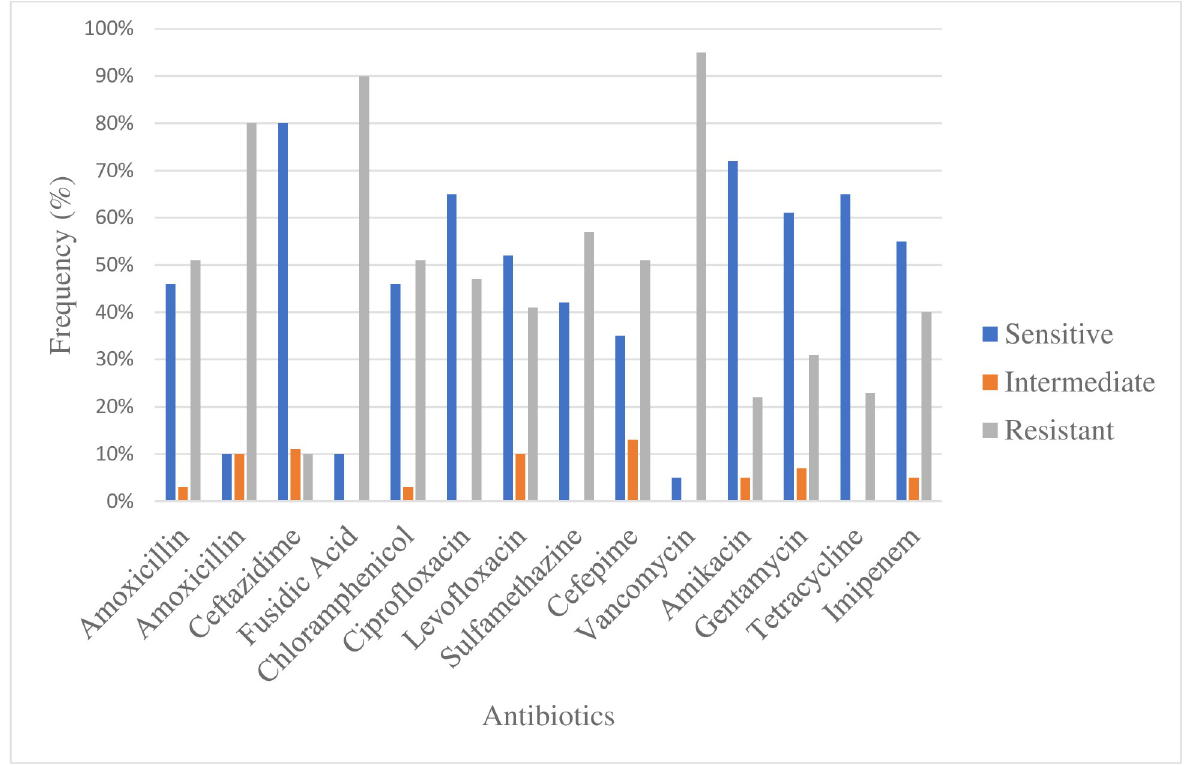
Fig 1. Antibiotics sensitivity pattern of MDR K . pneumoniae